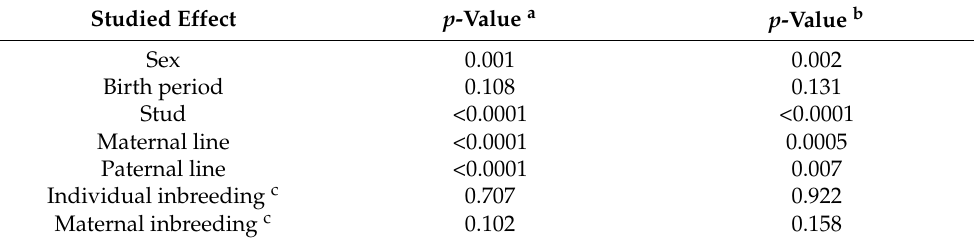
Table 3. Results of statistical analyses of studied factors of asthma morbidity.